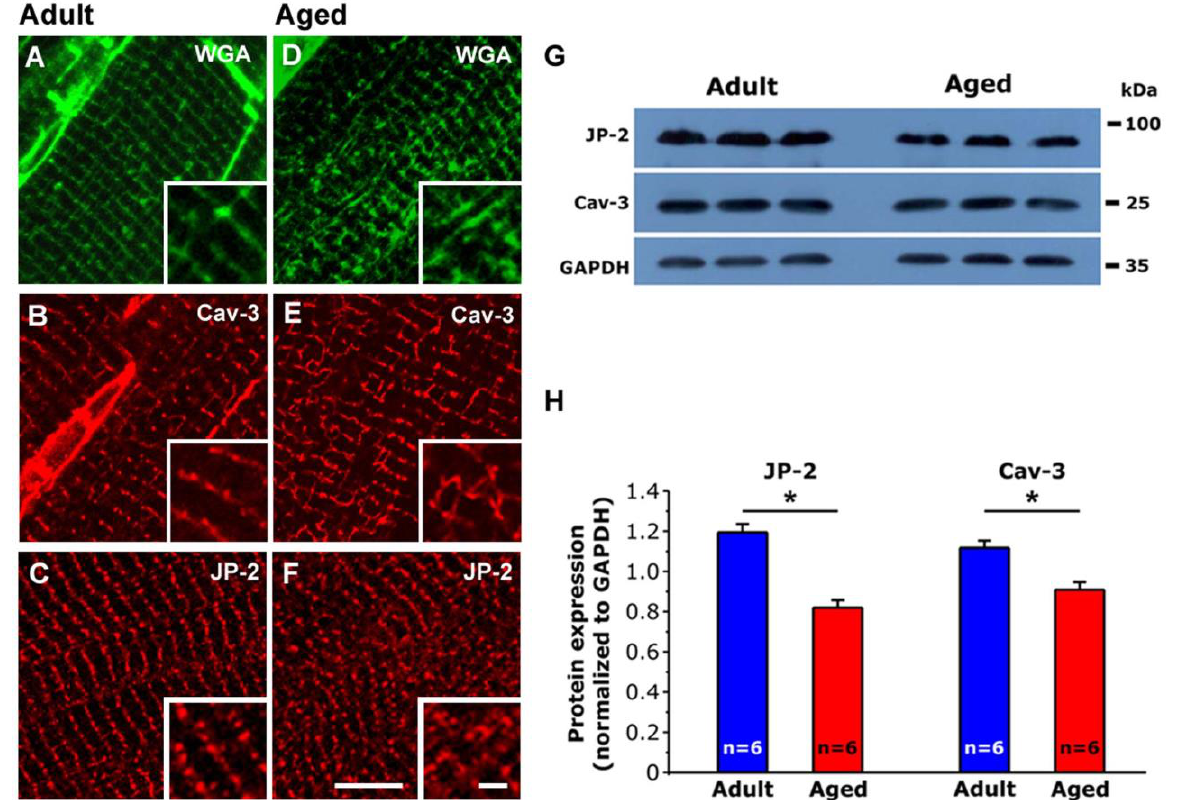
Figure 2. Immunolabeling of T-tubules and WB analysis of junctophilin-2 (JP-2) and caveolin-3 (Cav-3). ( A – F ) Immunofluorescence of cardiomyocytes stained with wheat germ agglutinin (WGA) and antibodies against JP-2 and Cav-3. ( G ) Representative immunoblot showing JP-2, Cav-3 and GAPDH (used as loading control), in whole cardiac tissue homogenates from adult and aged mice. ( H ) Bar plots showing the quantitative analysis of the relative JP-2 and Cav-3 expression levels by WB. Data in panel H are shown as mean ± SEM (* p < 0.01, unpaired two tailed t -test). n = number of mice. Scale bar: ( A – F ), 10 µm; inset, 2 µm.